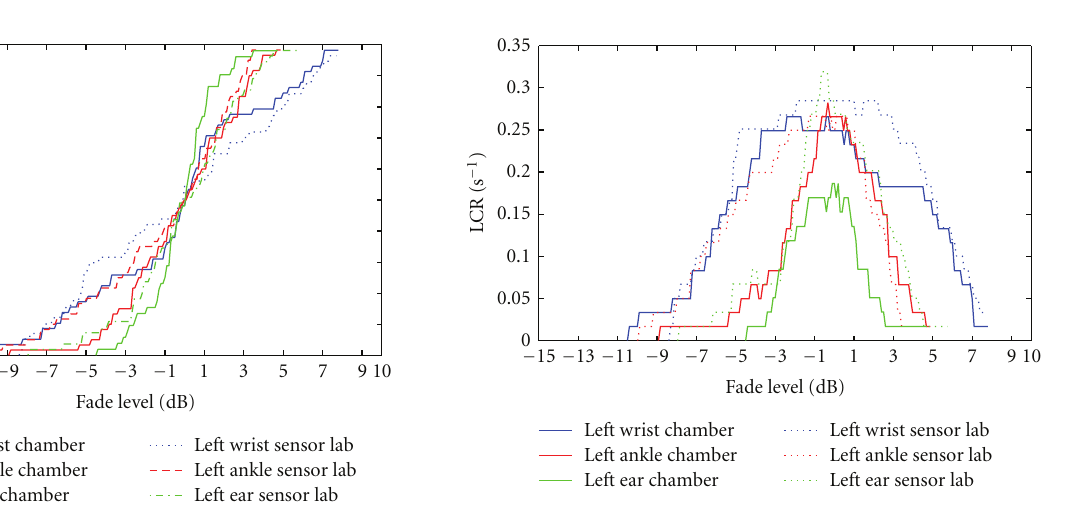
Figure 12: Comparison of fading probability (FP) for three di ff erent on-body channels as left wrist, left ankle, and left ear when subject was walking 5 steps ahead and back measured in the chamber and in indoor environment.